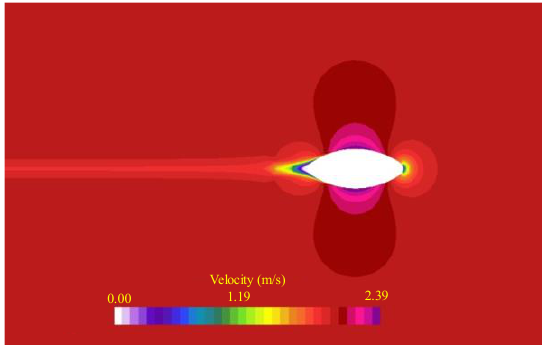
Figure 4. Velocity around the platform along the current.